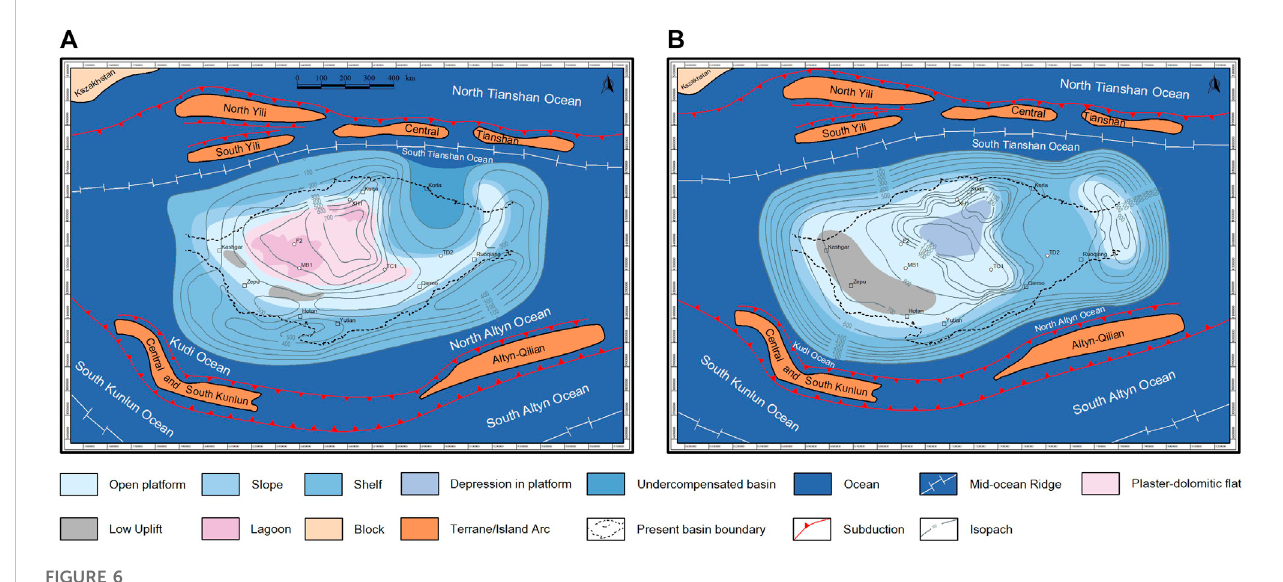
FIGURE 6 Proto-type basin of Tarim and adjacent areas in late Middle Cambrian (A) and late Cambrian (B)